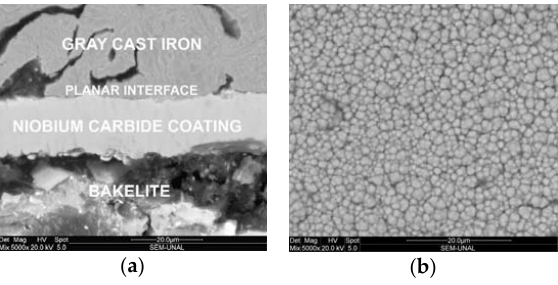
Figure 1. SEM micrograph 5000× of: ( a ) cross section and ( b ) surface of NbC 1223 K for 4 h.